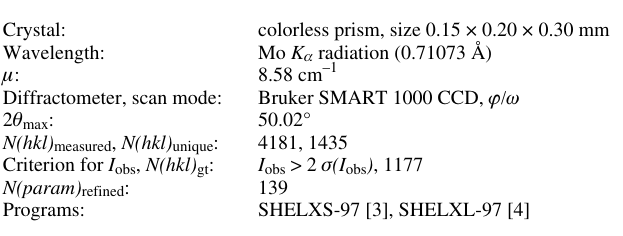
Table 1. Data collection and handling.